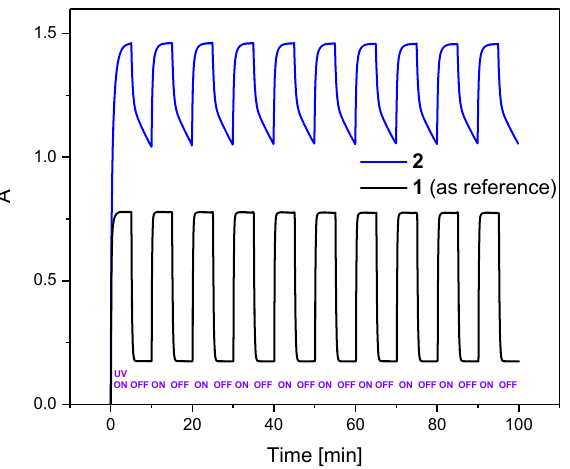
Figure 4. Kinetics of absorption upon switching on and off UV light at 365 nm (4.1 mW/cm 2 ) for 2 and 1 in cyclohexane probed at 430 nm using a Jasco spectrophotometer, temperature set at 21 °C. Solutions prepared with the same absorbance A(365 nm, 1 cm) =